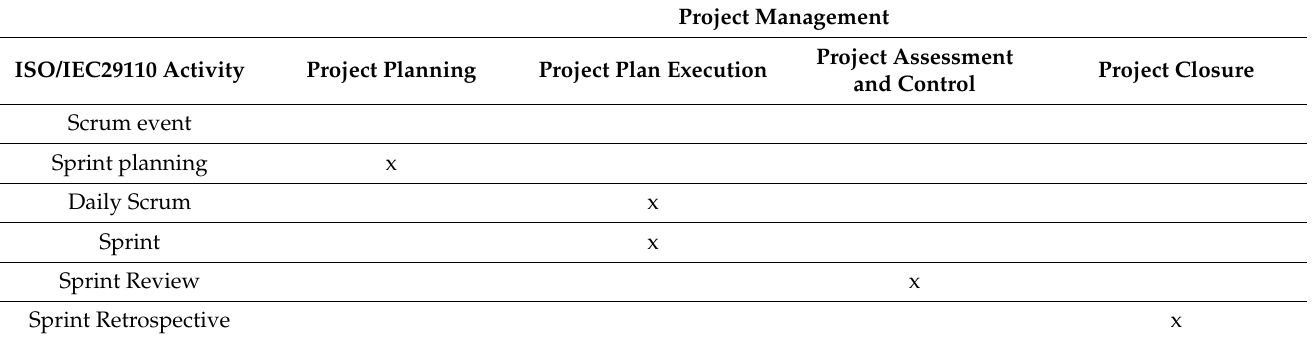
Table 5. The mapping of activities in the project management (PM) process and Scrum